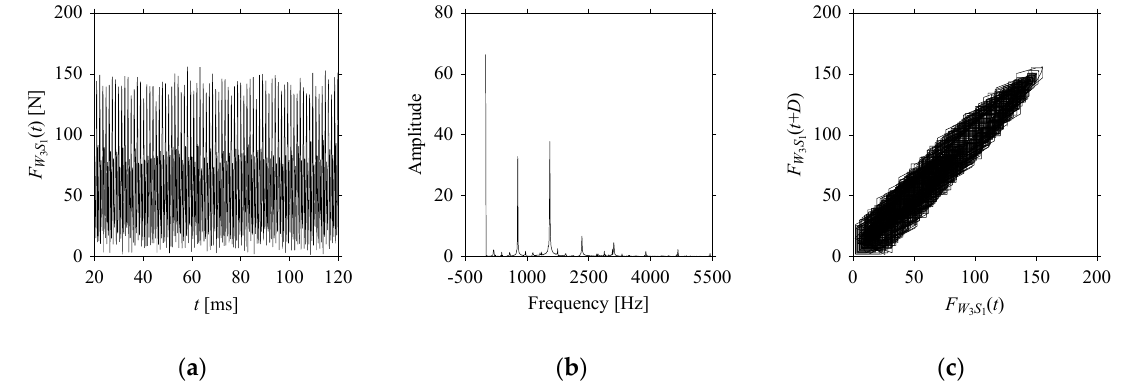
Figure A10. F W in the form of: ( a ) time series, ( b ) fast Fourier Transformation (FFT), and ( c ) delay map ( d = 1). 3 S 1